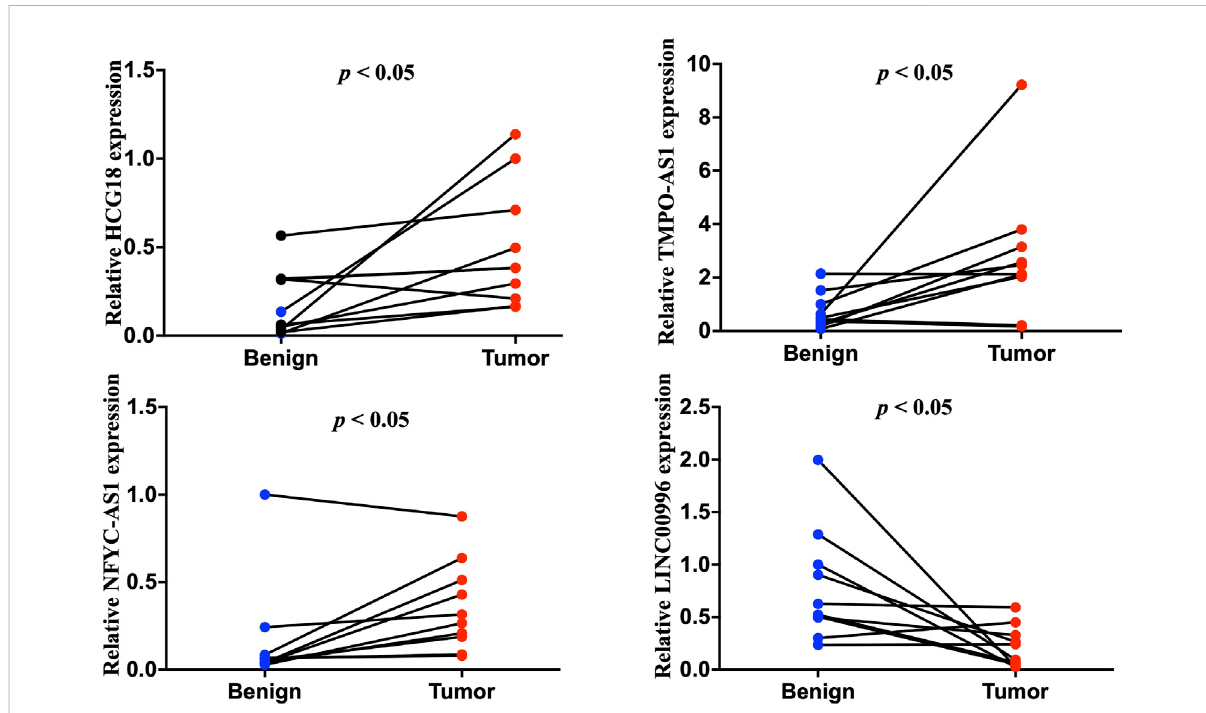
FIGURE 10 Quantitative reverse transcription polymerasereaction results of four lncRNAs, including HCG18,TMPO-AS1, NFYC-AS1, and LNC00996, from ten LUAD